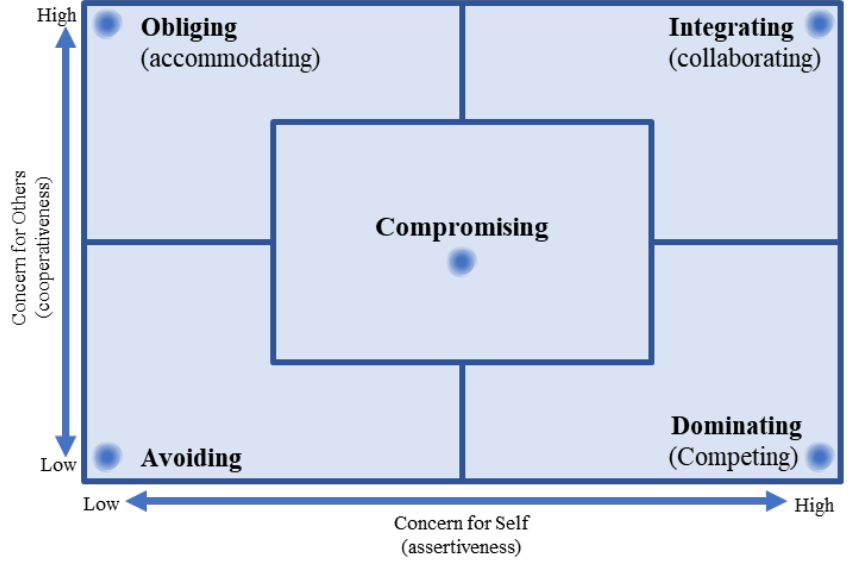
Figure 1. The Dual Concern Model